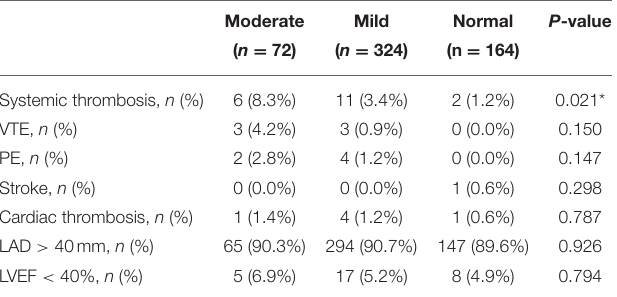
TABLE 2 | Assessment of clinical outcomes among different renal function categories.